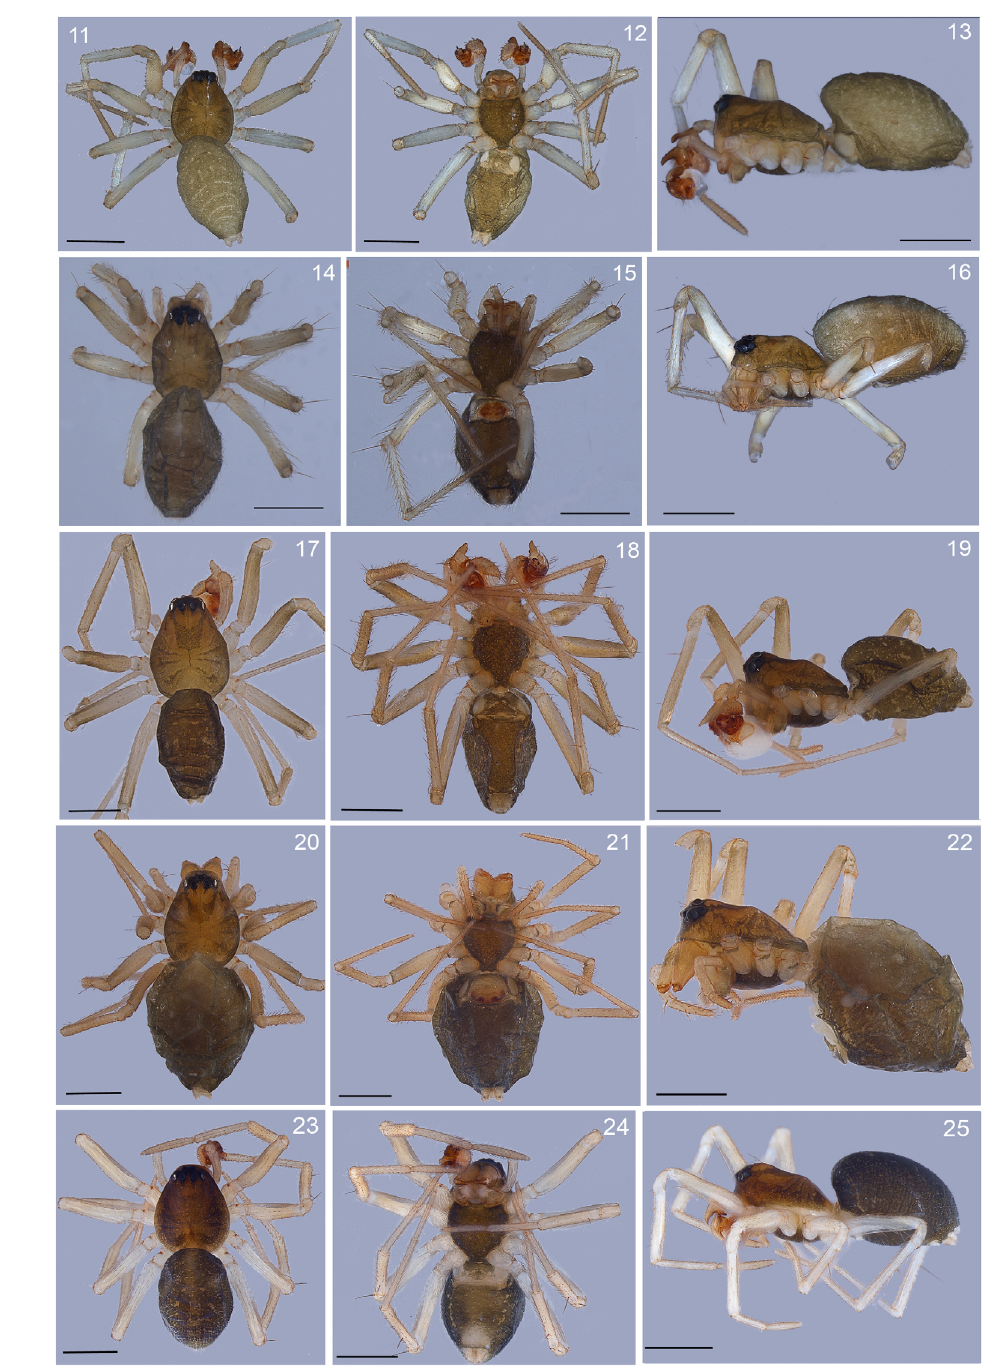
Figs 11-25. — 11-16 . Holmelgonia afromontana sp. nov. (♂ holotype, ♀ paratype 227154). 11 . Habitus, ♂, dorsal view. 1 2 . Habitus, ♂, ventral view. 13 . Habitus, ♂, lateral view. 14 . Habitus, ♀, dorsal view. 15 . Habitus, ♀, ventral view. 16 . Habitus, ♀, lateral view. — 17-22 . Holmelgonia bosnasutus sp. nov. (♂ holotype, female paratype 227507). 17 . Habitus, ♂, dorsal view. 18 . Habitus, ♂, ventral view. 19 . Habitus, ♂, lateral view. 20 . Habitus, ♀, dorsal view. 21 . Habitus, ♀, ventral view. 22 . Habitus, ♀, lateral view. — 23-25 . Holmelgonia disconveniens sp. nov. (♂ holotype). 23 . Habitus, dorsal view. 24 . Habitus, ventral view. 25 . Habitus, lateral view. Scale bars = 0.5